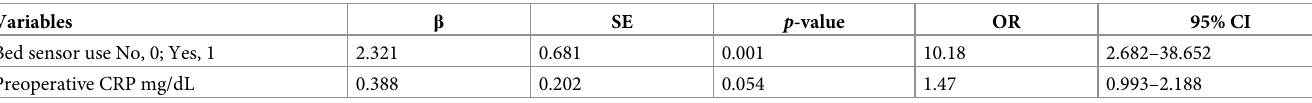
Table 7. Risk factors for both POD and SSD in the binary logistic regression analysis. Variables β SE p